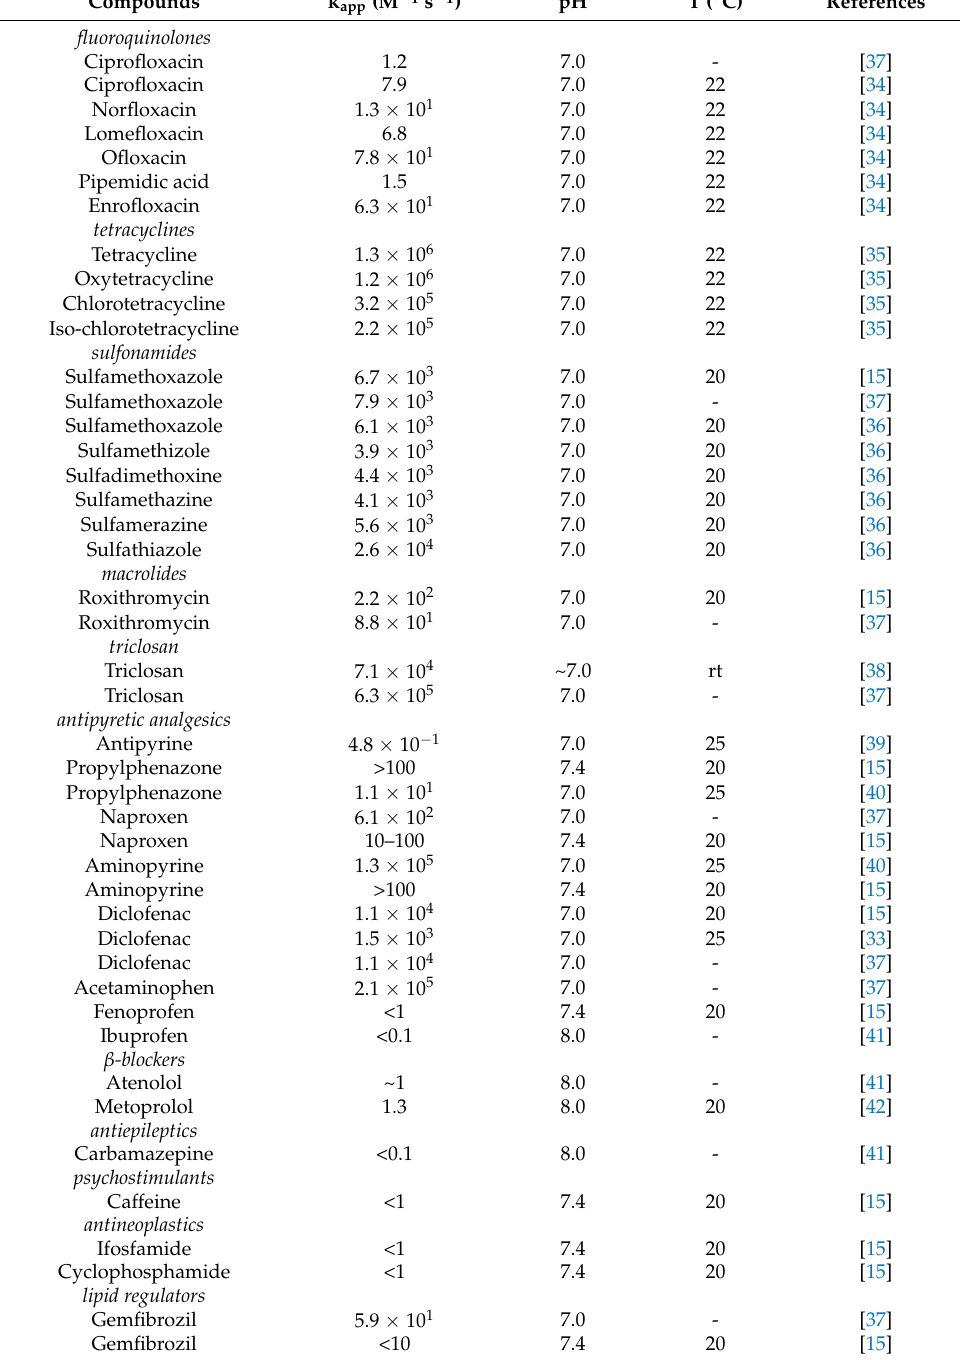
Table 1. Second-order rate constants (k app ) in the reaction of ClO 2 with micropollutants.